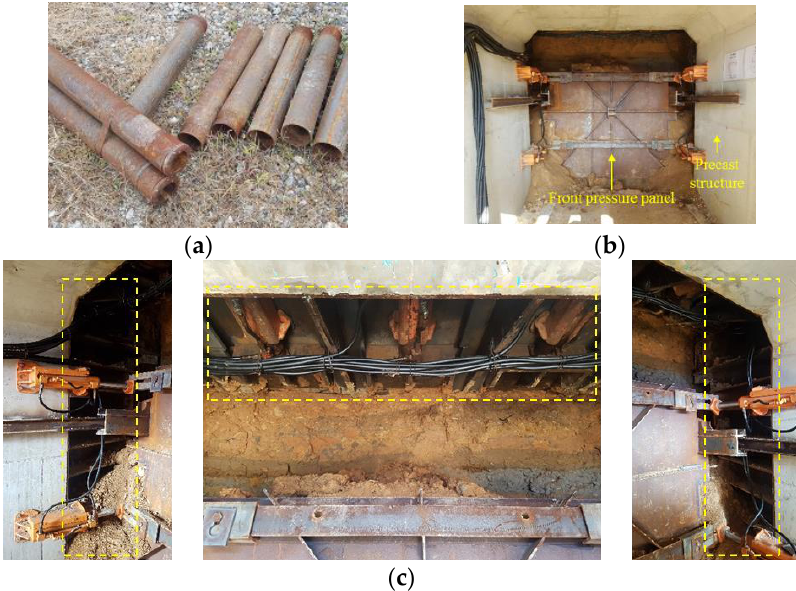
Figure 1. Actual composition of equipment: ( a ) small-diameter steel pipe piles. ( b ) Front pressure panel and precast structure. ( c ) Shoe structure (left, upper, and right).